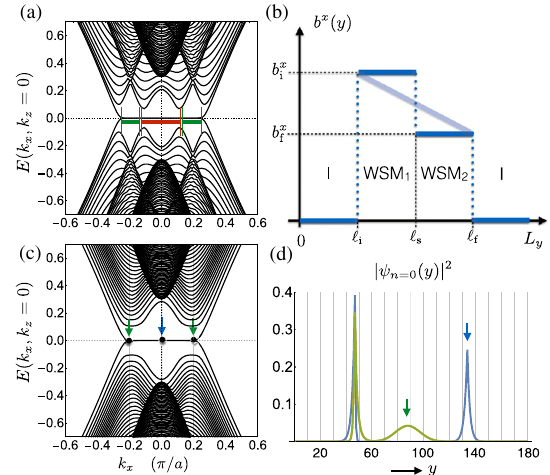
FIG. 7. Plot of the energy spectra (left panels) as a function of k obtained for the b x ð y Þ profiles shown in (b). The first case x (a) corresponds to a heterostructure of insulator (I) and a Weyl semimetal in which the separation of Weyl nodes changes abruptly from b x (WSM 1 ) to b x (WSM 2 ) at l ; see Eq. (36). s i f In (a), the zero energy states in the green region are associated with the “ mini-arcs ” localized at l , whereas the states marked by s red are associated with the interface between the Weyl semimetals and the insulator. In the second case (c), the separation of Weyl nodes is changed linearly between l and l [see Eq. (37)], as i f shown by the dark blue line. The wave-function support of states indicated by solid black dots in (c) is presented in